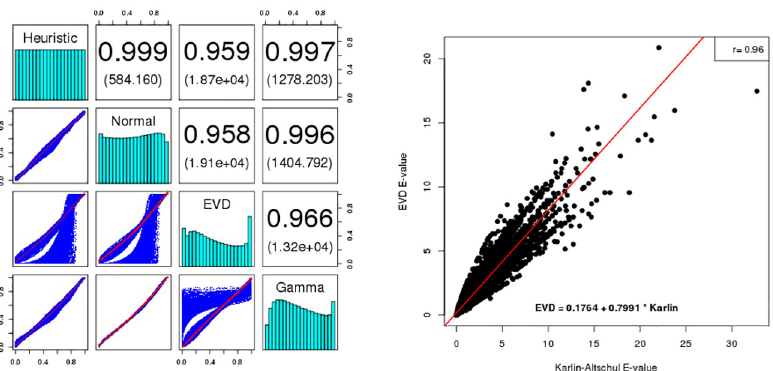
Fig 6. ( Left ) Pearson correlation values and scatter plots for p -values of semiglobal alignment scores between Rfam sequences and random RNAs. For 500 Rfam sequences, 1000 random semiglobal alignments were computed for 5 different gap penalties yielding the total of 2.5 million alignment scores. For each score a p -value is computed assuming Normal (ND), Gamma (GD) and Extreme Value (EVD) distributions in order to investigate which distribution is closest to the heuristic p -value, that is assumed to be the gold standard. Heuristic p -value for score z is determined by the proportion of alignment scores that exceed z . For all 2.5 million p -values, pairwise Pearson correlation values were computed and displayed in the upper triangular portion of the figure, with sums of squared residuals shown in parentheses, and histograms of p -values along the diagonal. It follows that ND p -values correlate best with heuristic p - values. ( Right ) Scatter plot of E-values computed by EVD fitting, E EVD , as well as our implementation of the Karlin- Altschul, E KA , for pairwise local alignments. The regression equation is E EVD = 0.1764 + 0.7991 � E KA ; Pearson correlation between E EVD and E KA is 96%, with correlation p -value of 2 � 10 − 16 indicating that p -values obtained from these two methods are in well agreement. E-values were determined from local alignment scores computed by